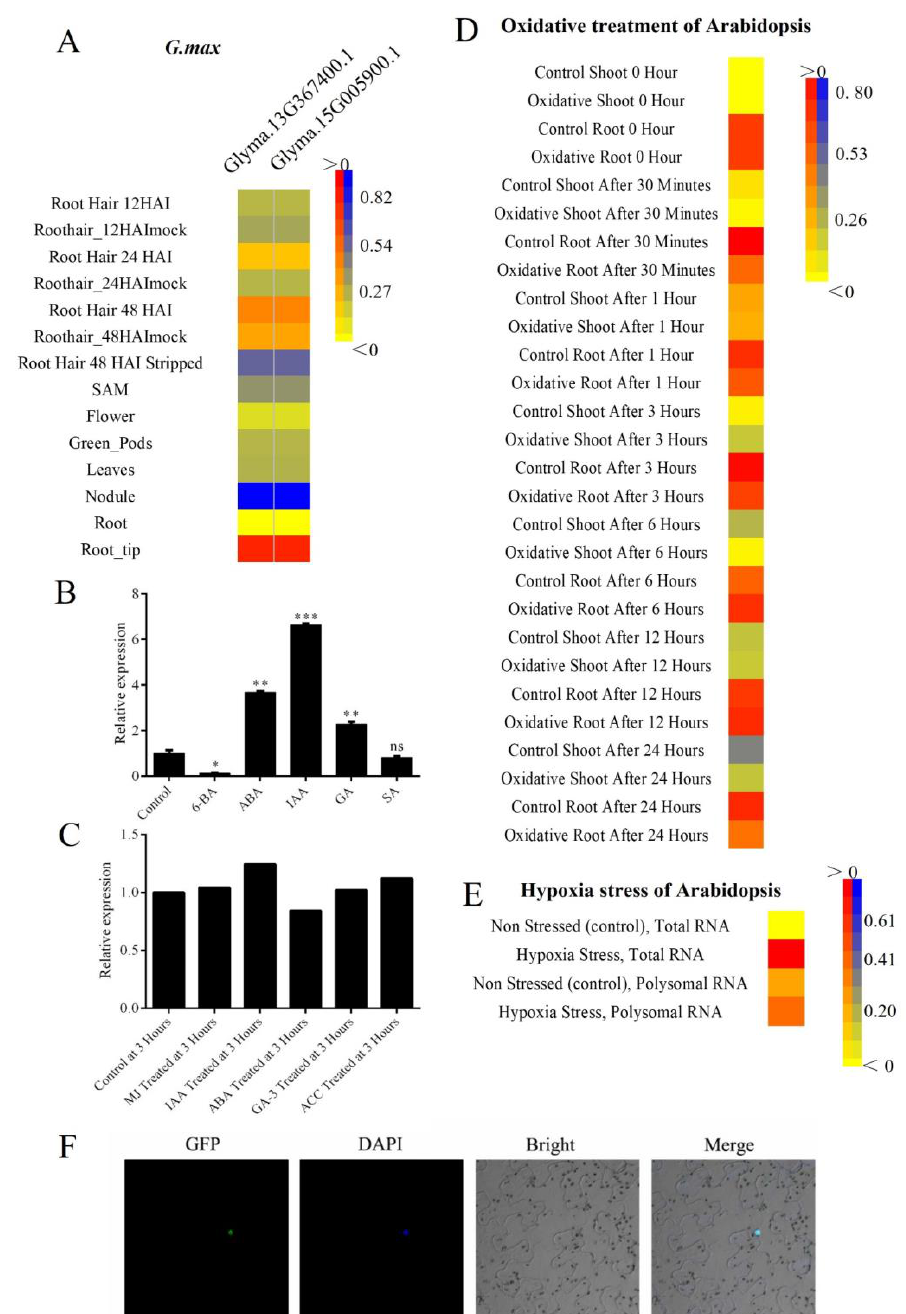
Figure 6. Spatial and temporal expressions of Glycine max SF3a2 and Arabidopsis thaliana SF3a2 . ( A ) Spatiotemporal expression patterns of two soybean genes. ( B ) Expression of ATSF3a2 under different hormone treatments with qPCR. GAPDH is the internal reference. The results shown are representative of three independent experiments. *** p < 0.001; ** p < 0.01; * p < 0.05; ns: no significant difference (Student’s t test). ( C ) Spatiotemporal expression patterns of ATSF3a2 under different hormone treatments. Data from BAR. ( D ) Spatiotemporal expression patterns of ATSF3a2 under oxidative treatments. ( E ) Spatiotemporal expression patterns of ATSF3a2 under hypoxia treatments. Expression data were extracted using the plant eGFP browser and are presented in heatmap format. Red and blue represent high and low expression in different tissues and stages, respectively. The bigger the difference, the darker the color. ( F ) Nuclear localization of ATSF3a2 in tobacco cells. Nuclei were labeled with 4 (cid:48) ,6 -diamidino-2-phenylindole